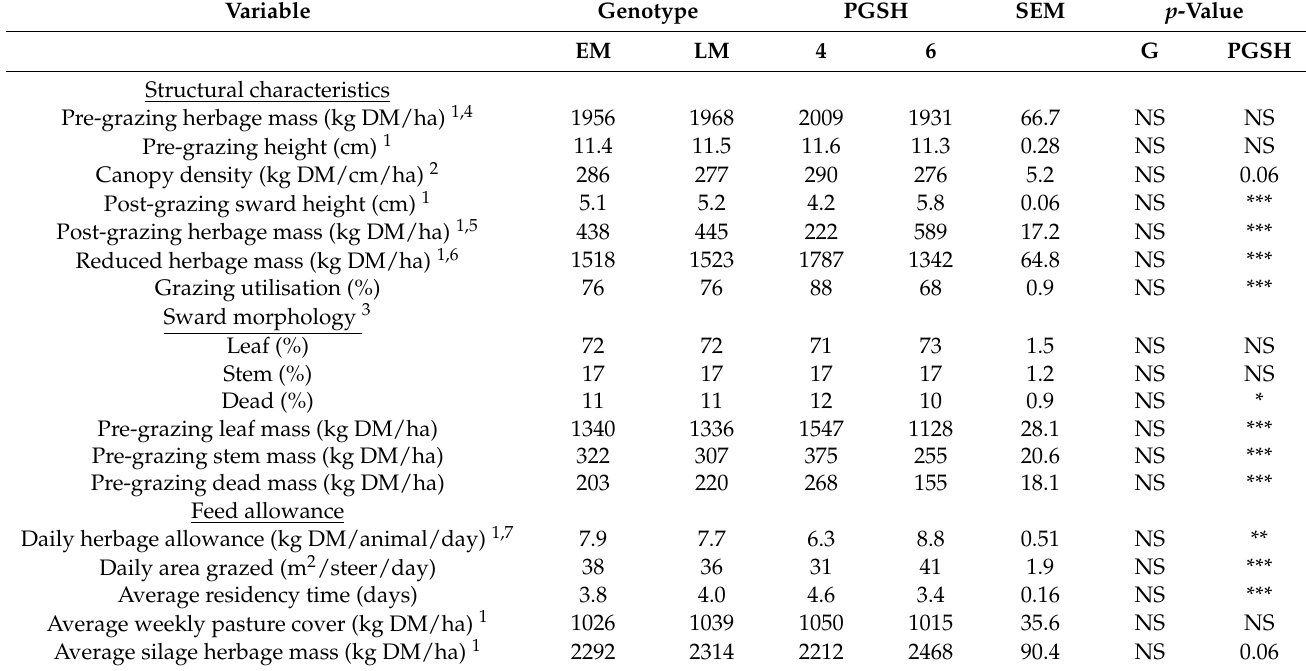
Table 1. Effect of genotype (G-early-(EM) or late-maturing (LM)) and post-grazing sward height (PGSH-4 or 6 cm) on sward structural characteristics, sward morphology and feed